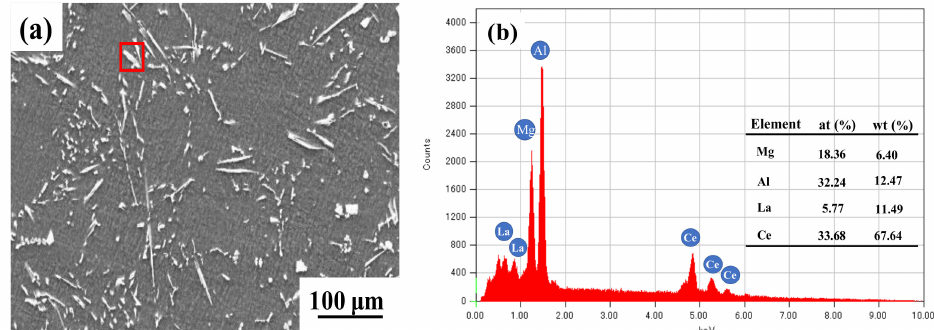
Figure 2. SEM morphologies ( a ) and the precipitation by EDS analysis ( b ) of as-cast Mg-RE alloy